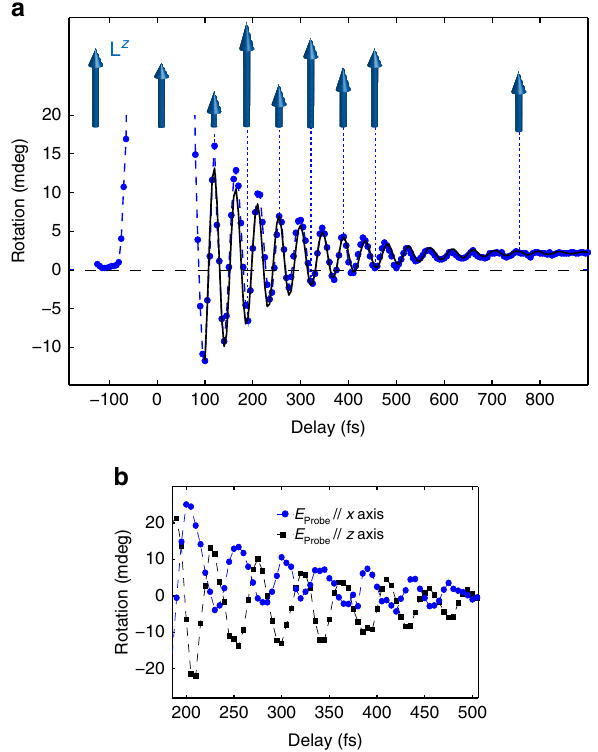
Figure 2 | Laser-induced dynamics of the antiferromagnetic vector. ( a ) The transient rotation of the probe polarization was measured with the electric fields of the pump and the probe beams linearly polarized along the z and x axes, respectively. The pump fluence was set to E 8.6mJcm (cid:2) 2 . The corresponding dynamics of L z (blue arrows) is schematically represented. When the pump pulses impinge on the sample (0 delay) L z decreases, due to the generation of magnons. At positive delays, oscillations at the frequency of the 2M mode are visible (equation (3)). The black line is a fit to the data (equation (13)). ( b ) The phase of the oscillation is shifted by p when the orientation of the electric field of the probe ( E Probe ) is rotated by 90 (cid:2) . The pump beam was linearly polarized along the z axis, the fluence was set to E 12mJcm (cid:2) 2 . The measurements reported in both panels were performed at